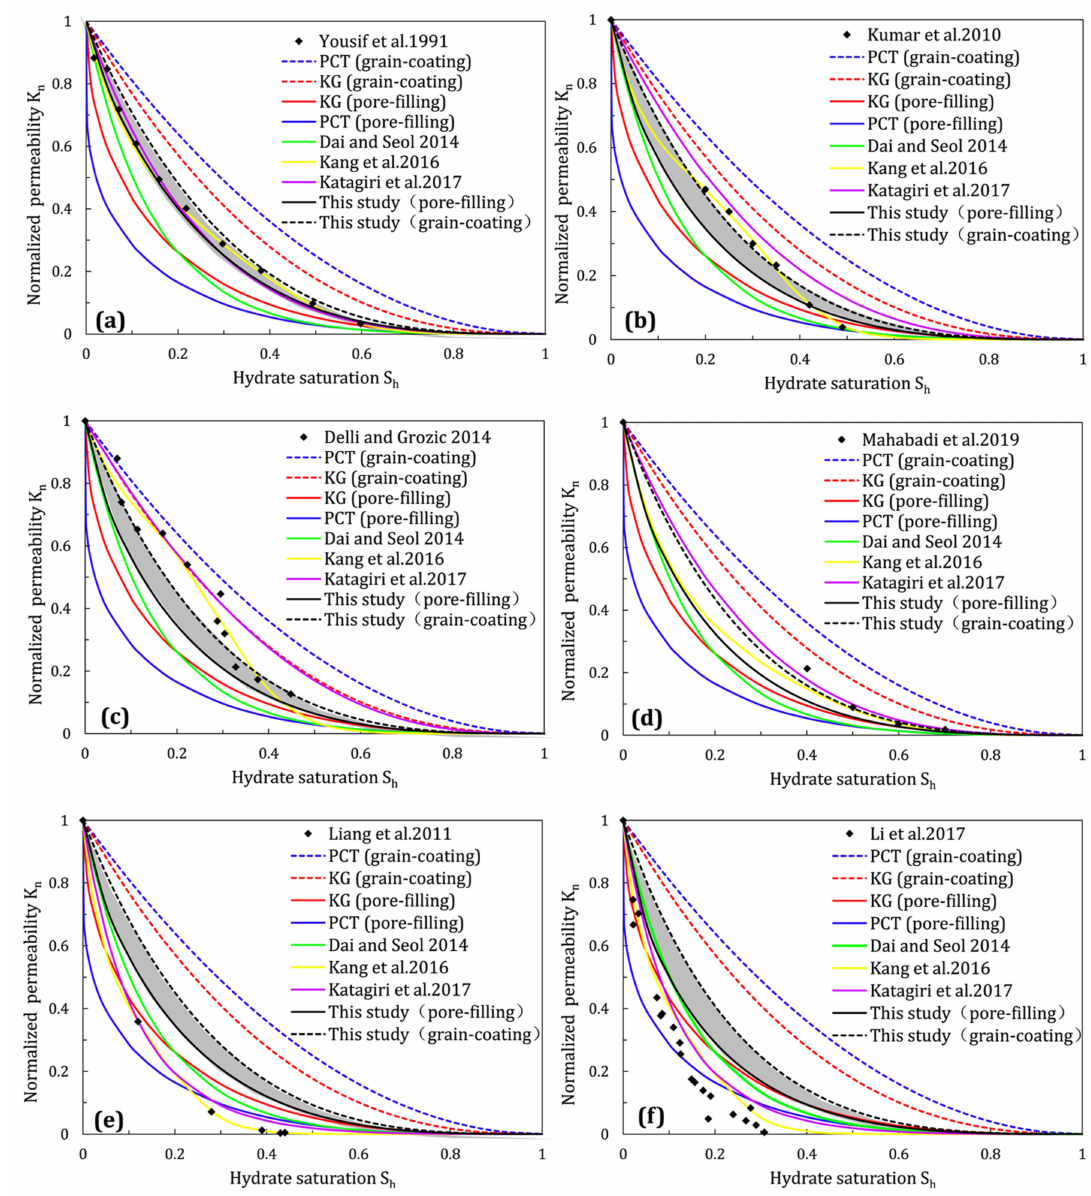
Figure 28. The verification of the new model reprinted from [58] with permission from Else- vier. The adopted existing KC-based models are from literatures [23,40,53,54]; experiment results: ( a ) Yousif et al. [111]; ( b ) Kumar et al. [82]; ( c ) Delli and Grozic [24]; ( d ) Mahabadi et al. [27]; ( e ) Liang et al. [95]; ( f ) Li et al.